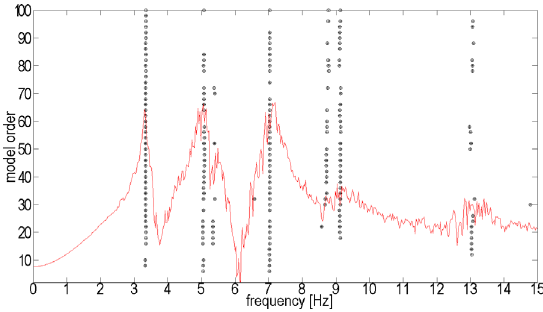
Figure 9. Stabilization diagram for Test 1. Figure 10. Singular value decomposition of spectral density ma- trices of Test 1 (EFDD technique). The peaks are